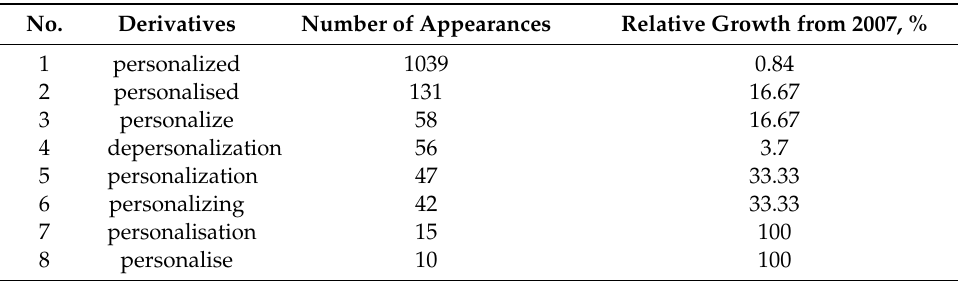
Table 3. Statistical results for derivatives with “personalis(z)e” as the root word extracted from the PubMed database for the period from 2007 to 2019 (black color in cyberspace).